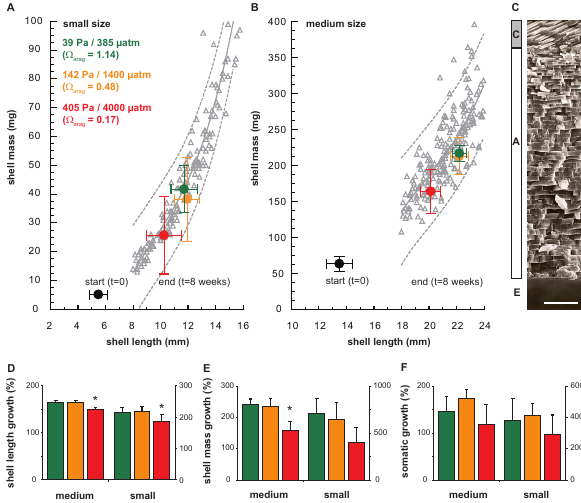
Figure 4 Fig. 4. (A) and (B) Shell mass vs. shell length relationships of small and medium experimental mussels at the beginning of the ex- periment (black) and after 8 weeks (red, orange, green; means and standard deviation). The grey symbols represent individual mussels from the collection site, the dashed line gives the 95% prediction interval for the shell mass vs. length relationship of wild mussels. (C) SEM cross-section of M. edulis shell (detail), showing the cal- cite (C) and aragonite (A) layers. Aragonite layers are in direct contact with the extrapallial fluid (EPF, E). Scale bar = 10µm. (D, E, F) Percent shell mass and length, as well as somatic (dry mass) growth over the entire 8 week period. See Table S1 (Supplement) for ANOVA Fig. 3. (A) haemolymph acid-base status in relation to environmen- tal p CO 2 (Davenport-diagram) for treatment groups at p CO 2 levels of 39Pa (385µatm, N = 12), 142Pa (1400µatm, N = 12) and 405Pa (4000µatm, N = 6). Isobars represent haemolymph p CO 2 . NBB = non-bicarbonate buffer line. Mussels cannot significantly elevate [HCO − ] to compensate pH e . See also Table S1A (Supplement) for 3 ANOVA tables; (B) Calculated haemolymph [CO 2 − ] at seawater 3 p CO 2 values of 39, 142 and 405Pa (385, 1400, 4000µatm). Black lines indicate seawater [CO 2 − ] and the corresponding CaCO 3 sat- 3 uration state ( (cid:127) arag ) .